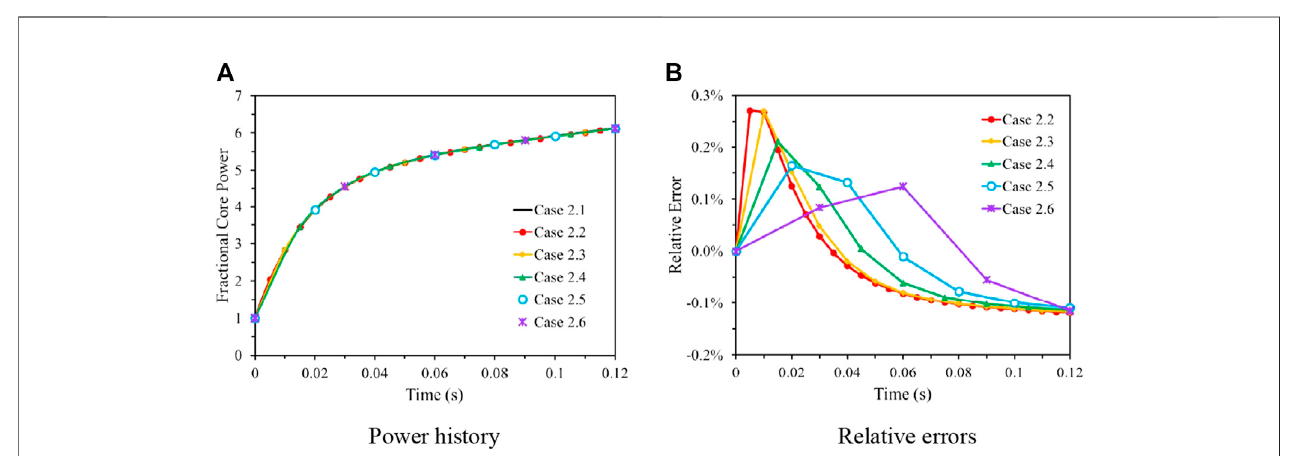
FIGURE 7 | The TML cases ’ s results in Problem 2. (A) Power history (B) Relative errors.